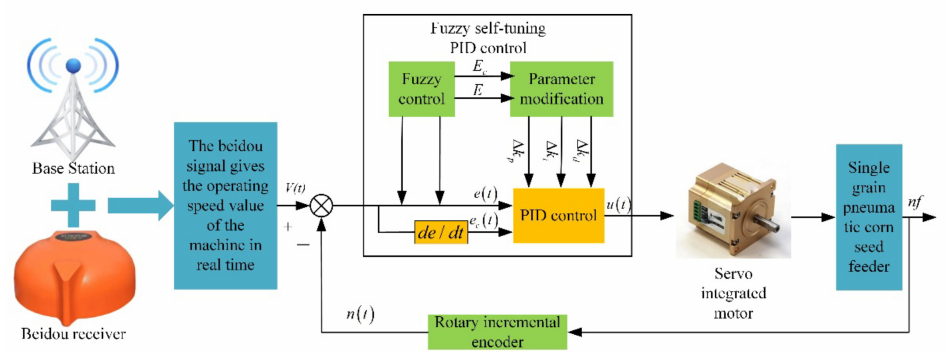
Figure 5. Double closed-loop speed control